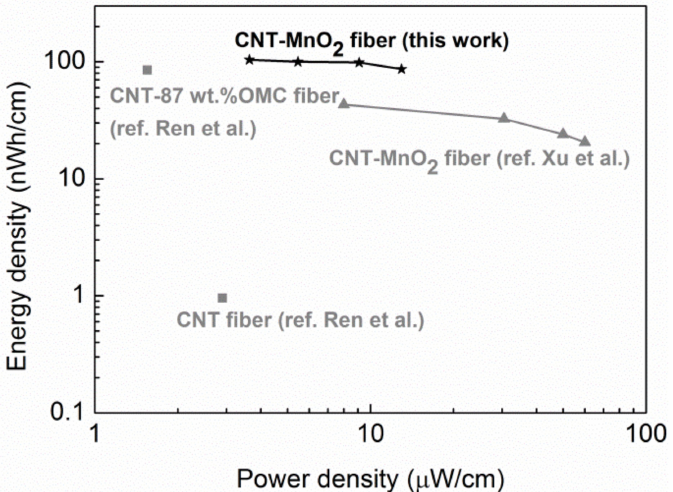
Figure 10. Ragone plots of length energy density versus length power density for the CNT–MnO 2 fiber supercapacitor fabricated in this work (black star); asymmetric supercapacitors based on pristine and MnO 2 -coated CNT fibers (grey triangle) [24]; and supercapacitors based on bare CNT fiber and CNT-OMC fibers (grey square)